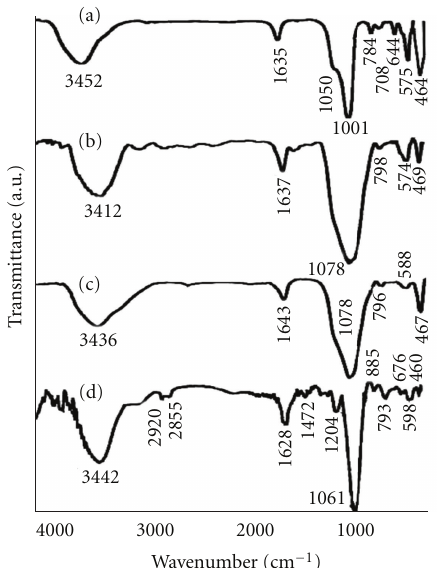
Figure 3: FT-IR spectra of (a) zeolite Y, (b) NCY, (c) Fe-NCY, and (d) Fe-OP-NCY samples.